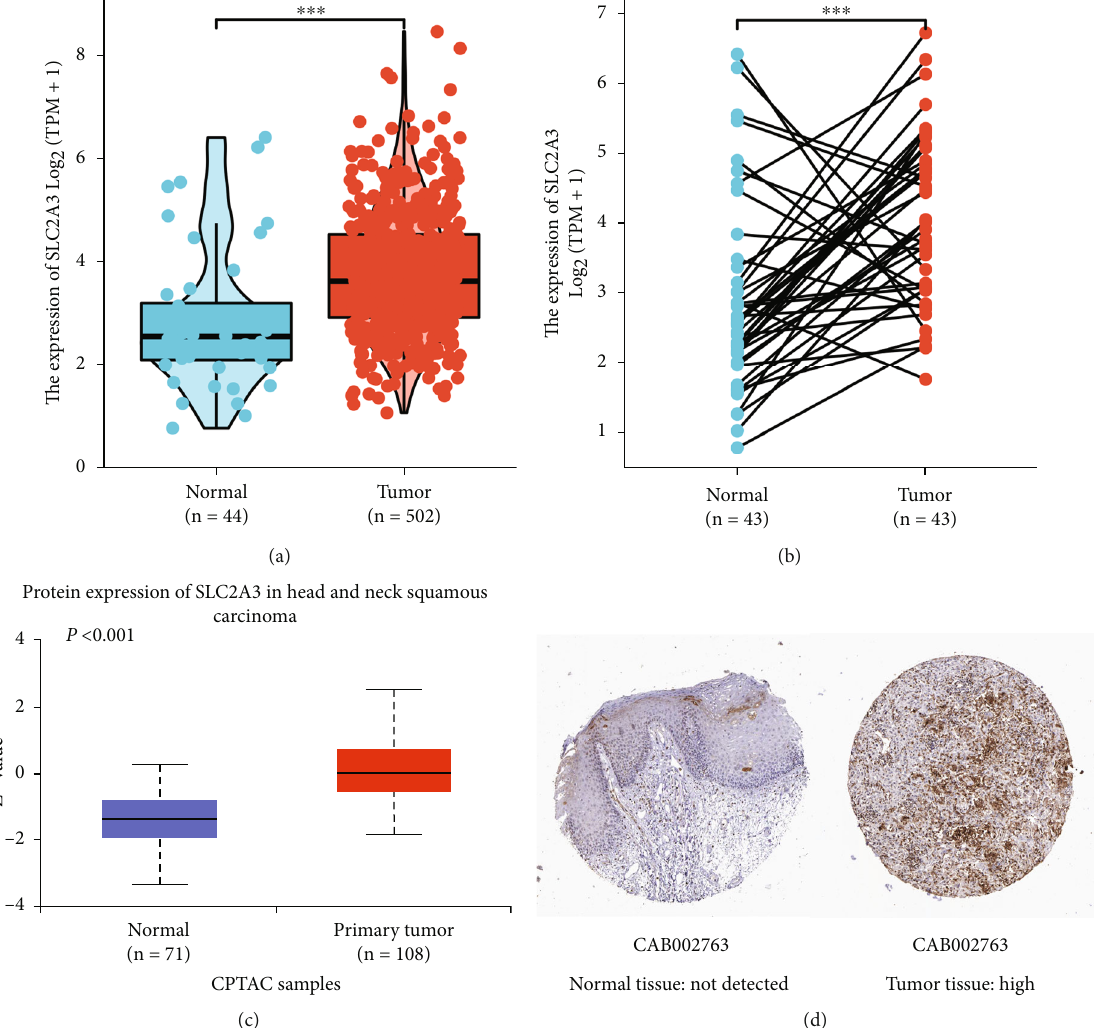
Figure 2: Gene expression levels of SLC2A3 in normal tissues and tumor tissues by unpaired analysis (a) and paired analysis (b). Protein expression levels of SLC2A3 in normal tissues and tumor tissues based on CPTAC (c) and HPA (d). ð ∗∗∗ P < 0 : 001 Þ